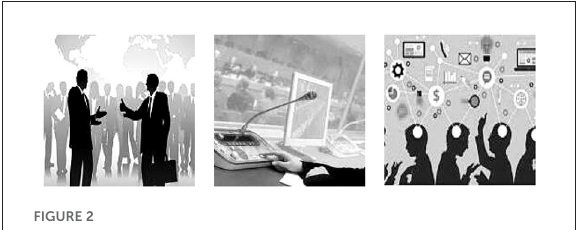
FIGURE2 Business English, translation, and business.